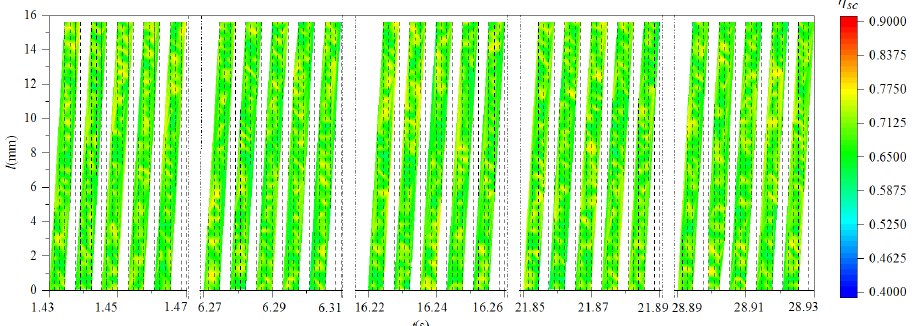
Figure 20. The distributive variation in shear energy efficiency of cutter teeth (scheme 2).